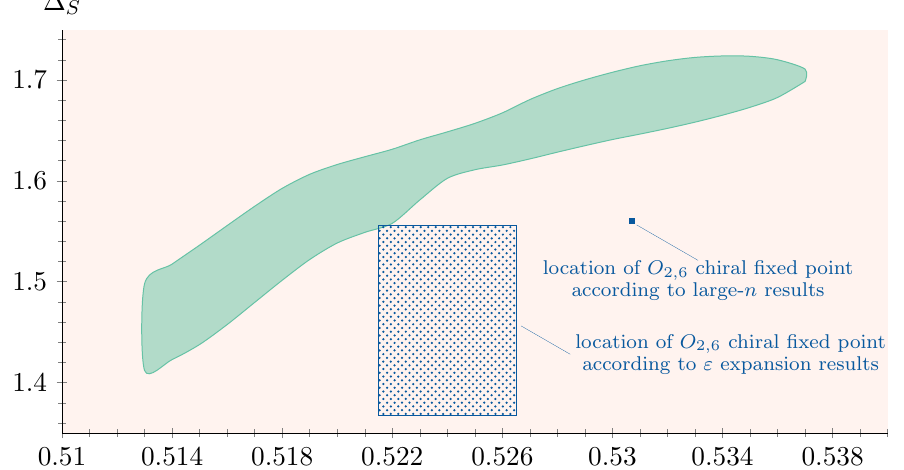
Figure 9: Allowed region (in green) for the O according to (8) and the (cid:34) expansion results of [ 27, Table 9 ] . This island is obtained with the assumptions (C-1)-(C-5) using saturation of the O